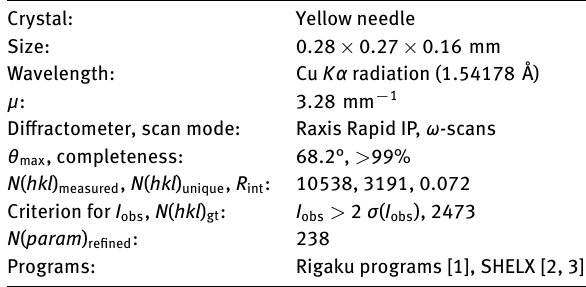
Table 2: Fractional atomic coordinates and isotropic or equivalent isotropic displacement parameters (Å 2